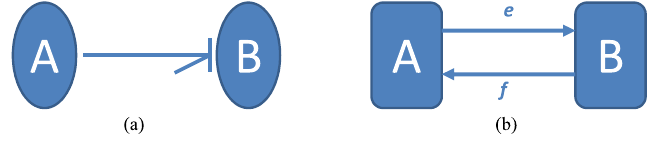
Figure 3. ( a ) Causal Bond Graph (BG) and ( b ) corresponding block diagram representation. Table 1. Flow and effort for various energy